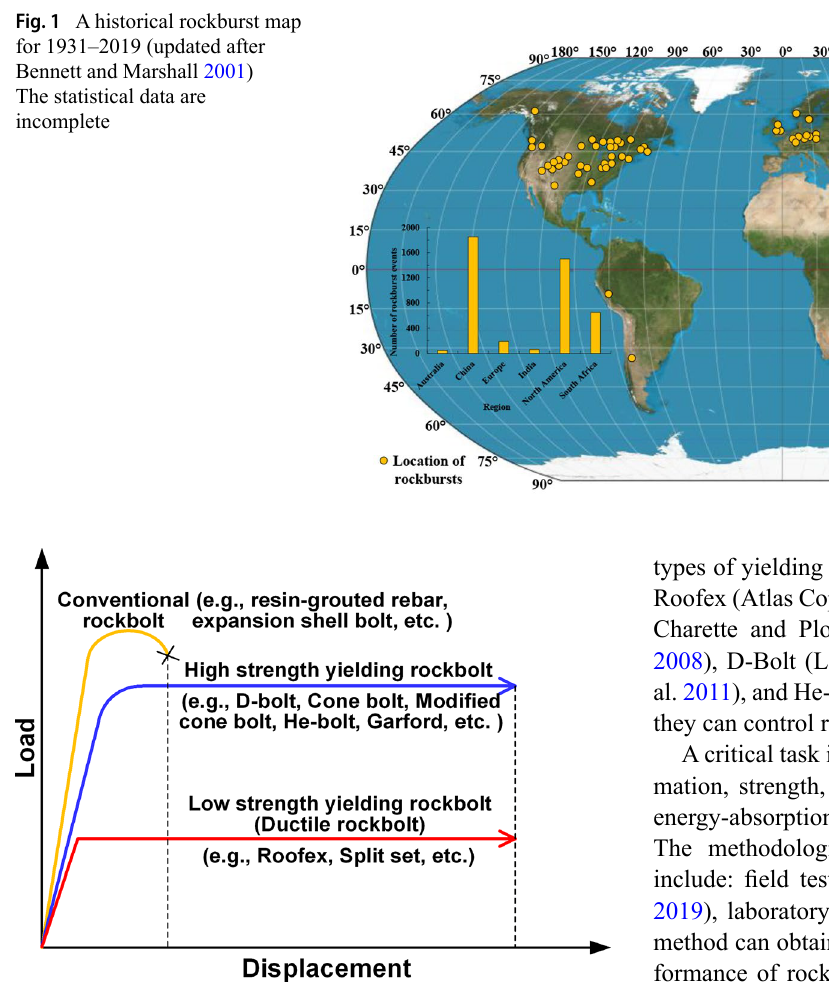
Fig. 2 Load-displacement characteristics of conventional and yielding rockbolts (after Li et al. 2014)